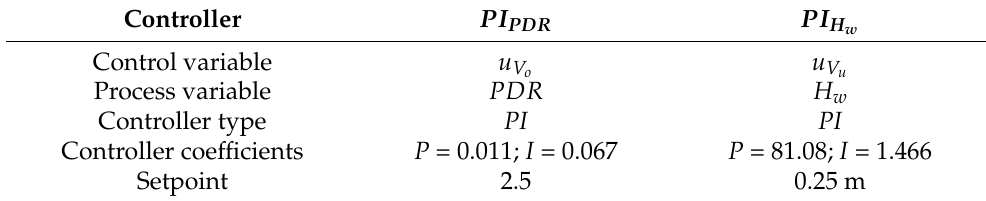
Table 1. Common controller